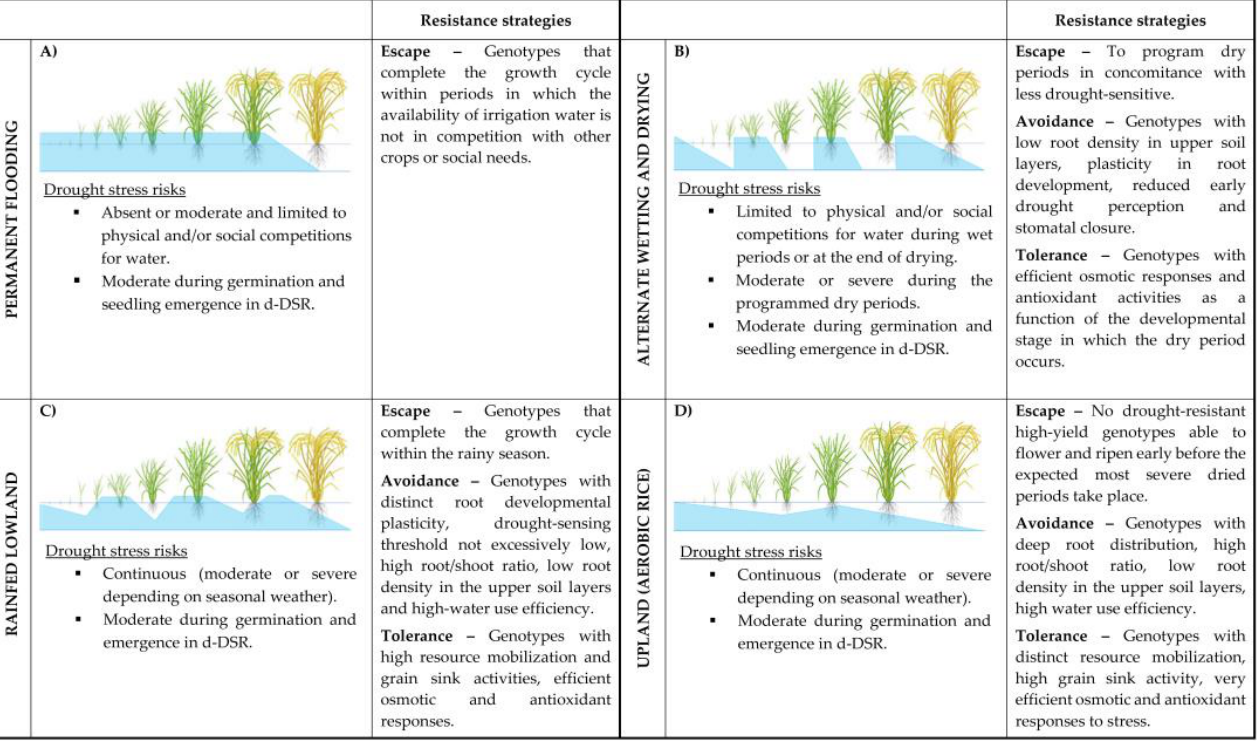
Figure 1. Water management of rice fields, associated drought-stress risks, and appropriate resistance strategies. Details about the different water management strategies of the paddy field ( A – D ) and the resistance strategies are reported in the text. Light blue areas indicate the water-saturated ( Ψ w = 0) soil zones. The areas over the horizontal lines indicate the presence of a 5–20 cm water head above the soil surface. Correspondences between soil water level and plant developmental stages are only indicative. d-DSR: dry Direct Seeding Rice.